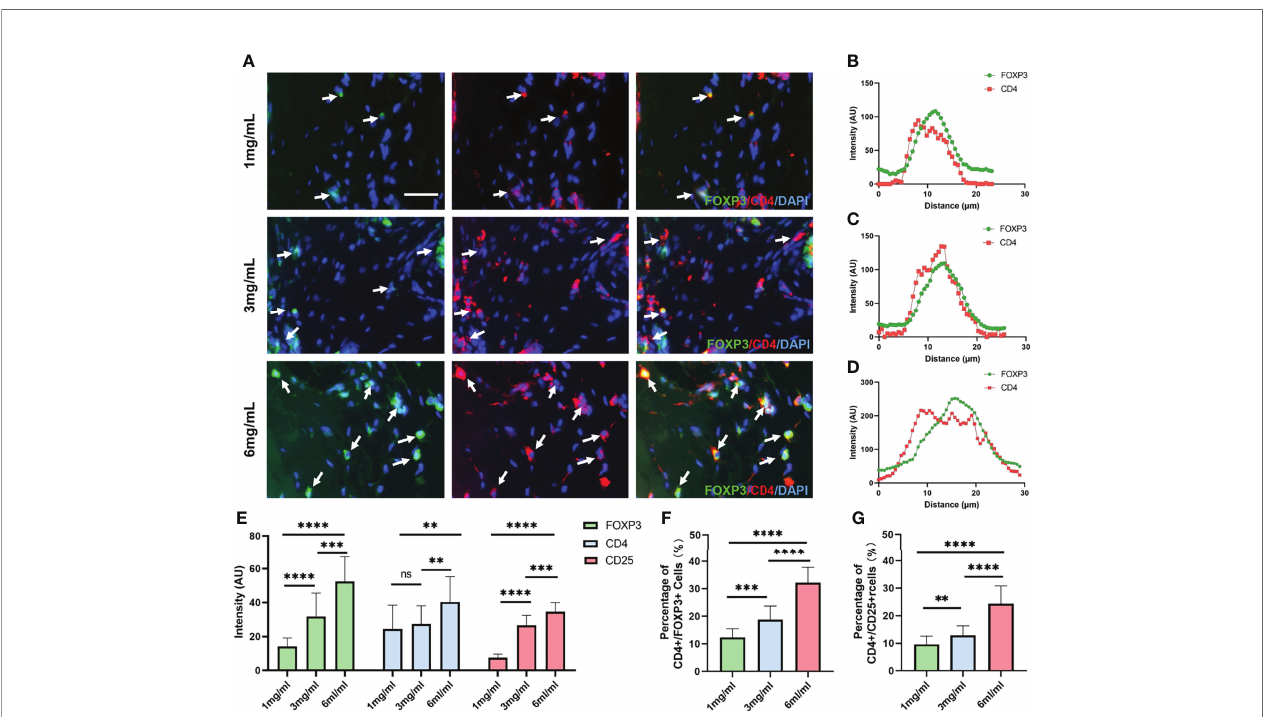
FIGURE 8 | Collagen concentration regulates the expression levels of Treg biomarkers. (A) Immuno fl uorescence staining of FOXP3 and CD4 in Jurkat T cells encapsulated in different collagen concentrations. (B) Colocalization analysis of FOXP3 and CD4 in Jurkat T cells encapsulated in 1 mg/ml collagen matrix. (C) Colocalization analysis of FOXP3 and CD4 in Jurkat T cells encapsulated in 3 mg/ml collagen matrix. (D) Colocalization analysis of FOXP3 and CD4 in Jurkat T cells encapsulated in 6 mg/ml collagen matrix. (E) Average fl uorescence intensity of FOXP3, CD4 and CD25 among different collagen concentration groups. (F) Percentage of CD4+/FOXP3+ T cells among different collagen concentration groups. (G) Percentage of CD4+/CD25+ T cells among different collagen concentration groups. (scale bar, 50 m m). ns, not signi fi cant. ** p < 0.01, *** p < 0.001, **** p <